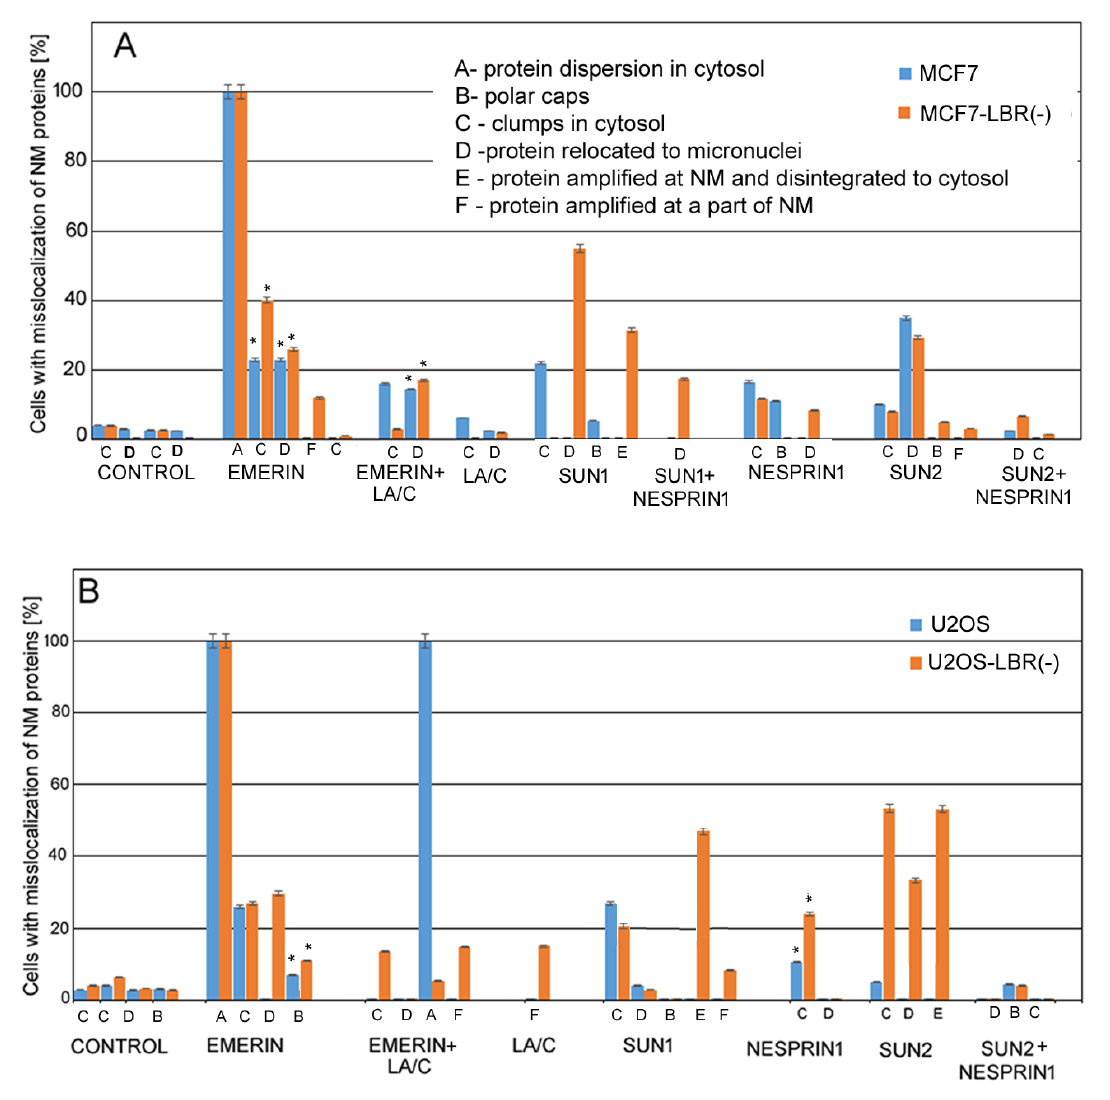
Figure 4. Graphical presentation of mislocalization frequency of LINC complex proteins (nesprin-1, SUN1, SUN2), emerin, and LA / C in irradiated cells. ( A ) MCF7 cell line and derived LBR(-) cells, ( B ) U2OS cell line and derived LBR(-) cells. The data are presented as a percentage from the mean cell number ± SE. The di ff erences between parental cells and derived clones were significant for almost all LINC complex proteins. The data were collected from 3 independent experiments and more than 100 cells were counted in each. In less obvious cases, di ff erences between LBR(-) and original cells were statistically evaluated ( t -test, p ≤ 0.05, asterisks).